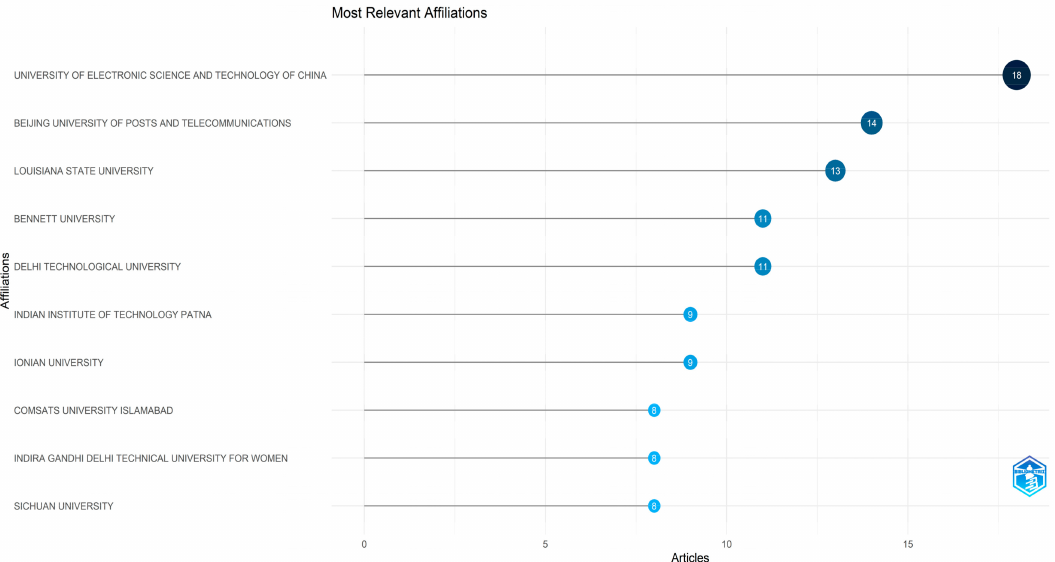
Figure 11. Relevant affiliations.